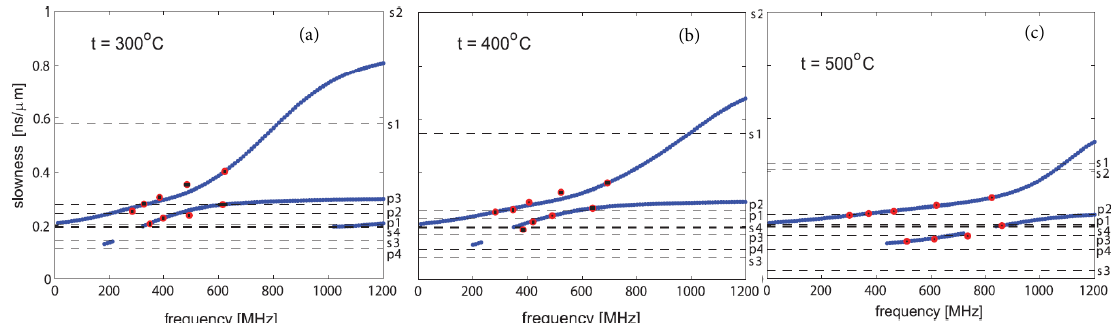
Figure 11. Illustration of the influence of annealing temperature; “ pyramidal ” NWs as in Figure 5a at different temperatures: ( a ) t = 300 ◦ C, ( b ) t = 400 ◦ C and ( c ) t = 500 ◦ C; effective input parameters are